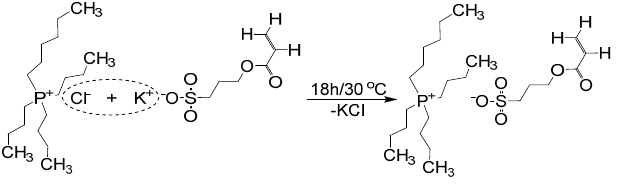
Table 1. Monomeric mixture compositions for the synthesized hydrogels.